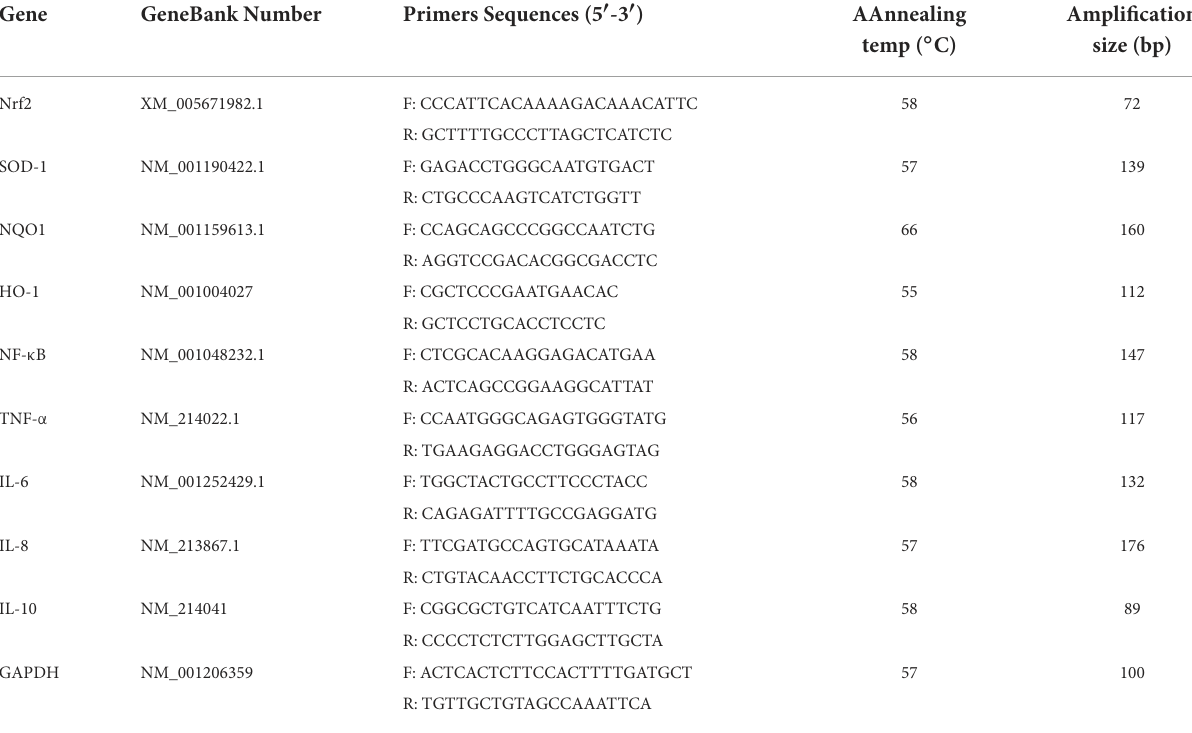
TABLE 3 Primers used in this